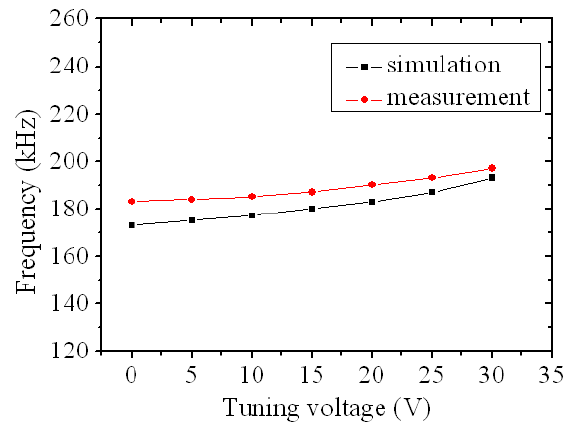
Figure 14. Resonant frequency vs. tuning